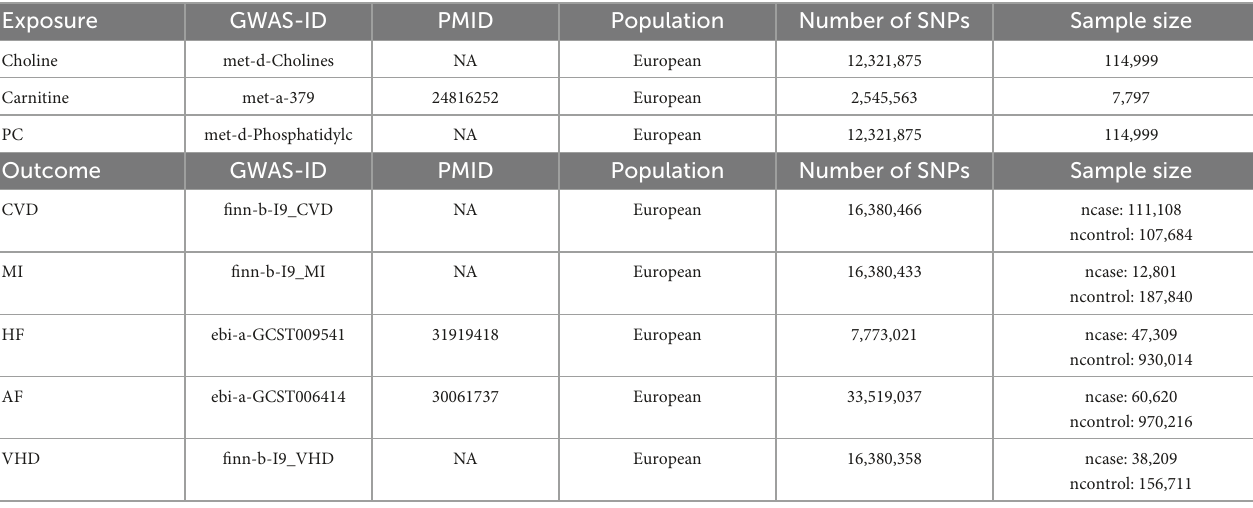
TABLE 1 Basic information about the GWAS